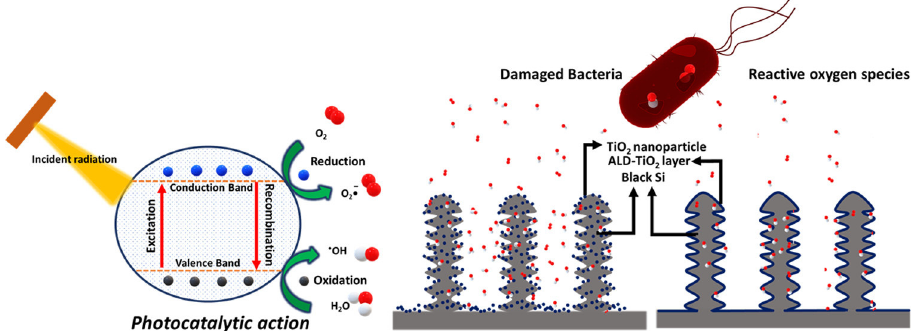
Figure 4. Antibacterial TiO 2 nanoparticle hybrid nanostructures. The photocatalytic ROS generation on bacterial-disruptive nanostructures presents a low-cost antibacterial technology. Reprinted with permission from [124]. Copyright 2022, The Authors. Published by American Chemical Society.